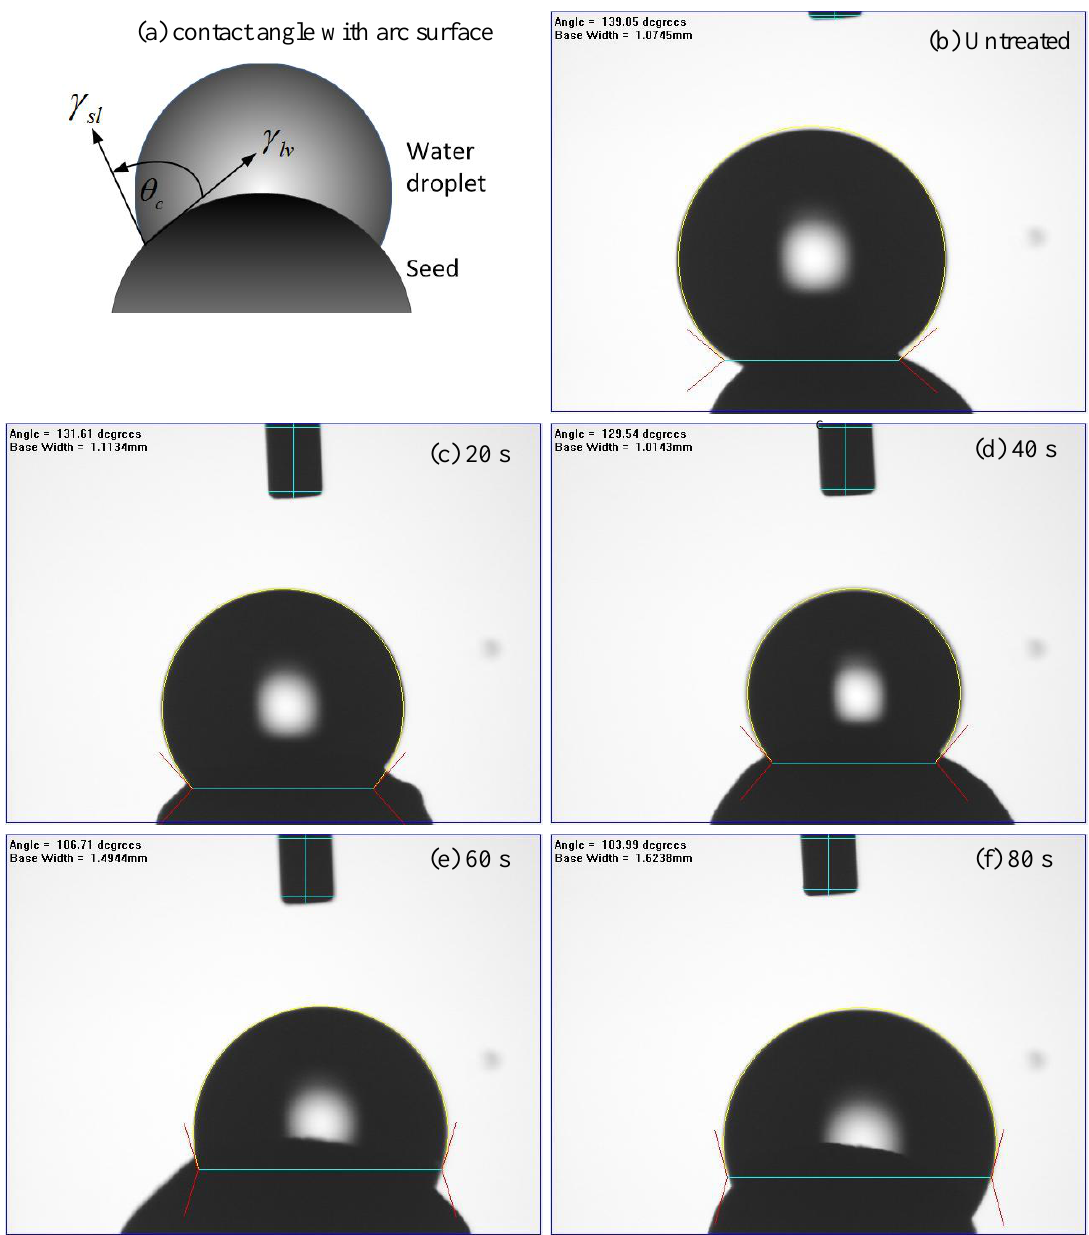
Figure 6. Contact angle measurement ( a ) schematic diagram of the contact angle with the arc surface, ( b – f ) contact angle images of the water droplet on broccoli seed with different treatment times.